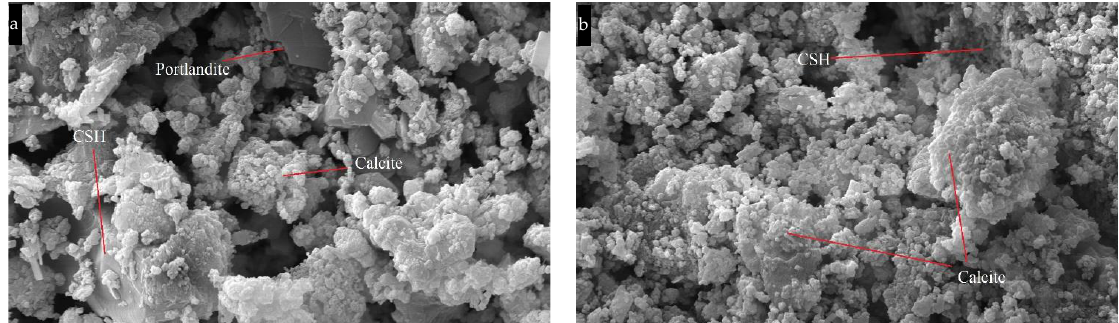
Figure 20. SEM images of OSA compacts 5000× magnified (( a ) hydrated, ( b ) cured at 25 °C, 10 bar, 100% CO 2 , 150 kgf/cm 2 ).